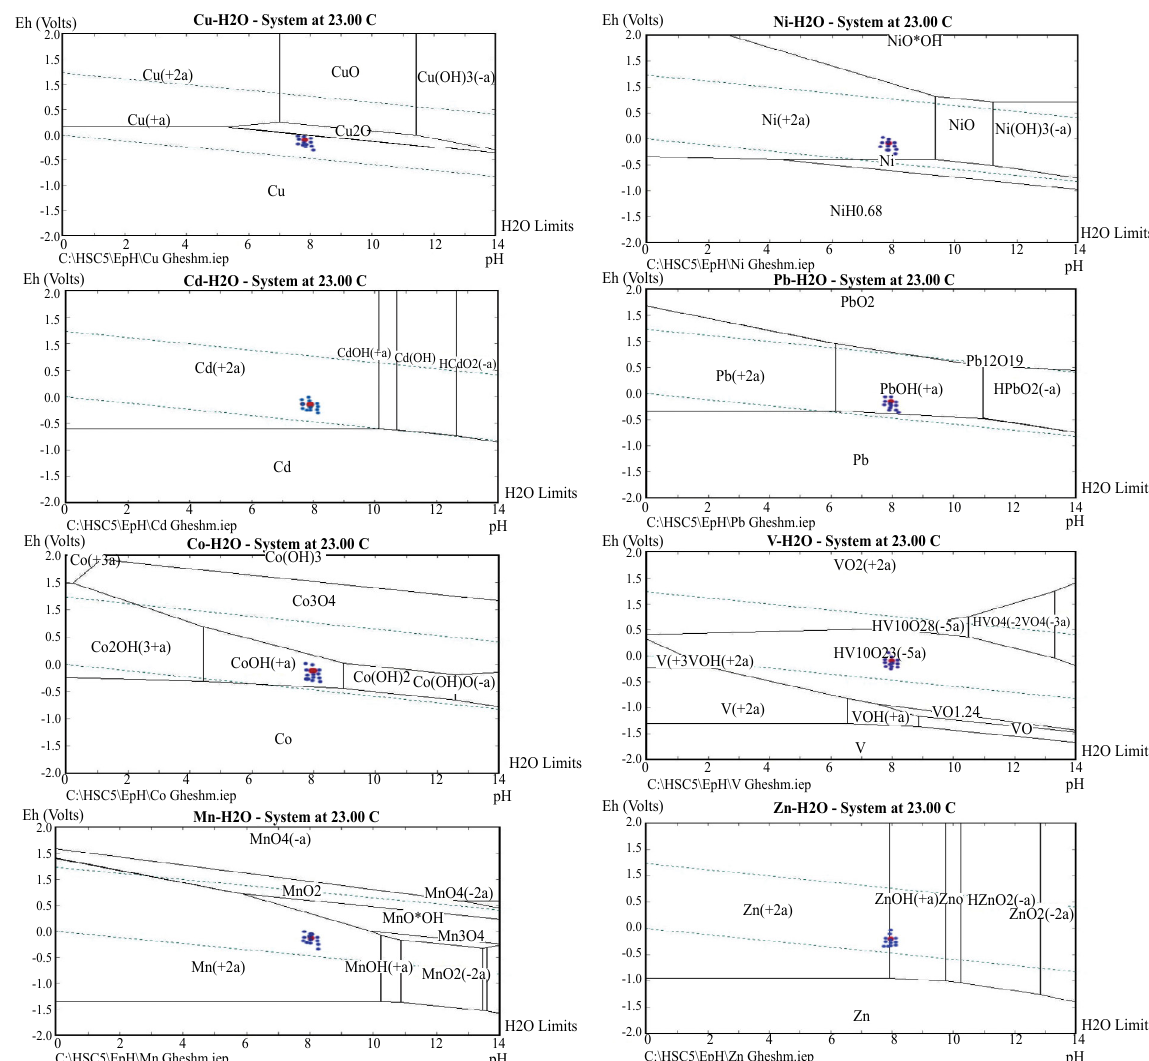
Fig. 3: Speciation of heavy metals (Cu, Cd, Co, Mn, Ni, Pb, V and Zn) in coastal waters of Qeshm Island Table 2: Summary of speciation status of heavy elements within various ranges of Eh-pH in the Persian